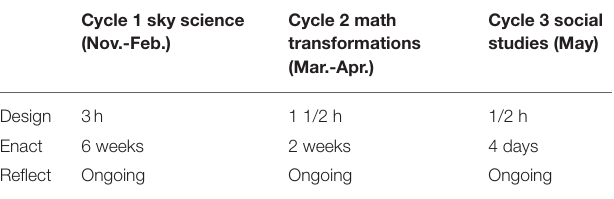
cycles. Cycle 1 sky science